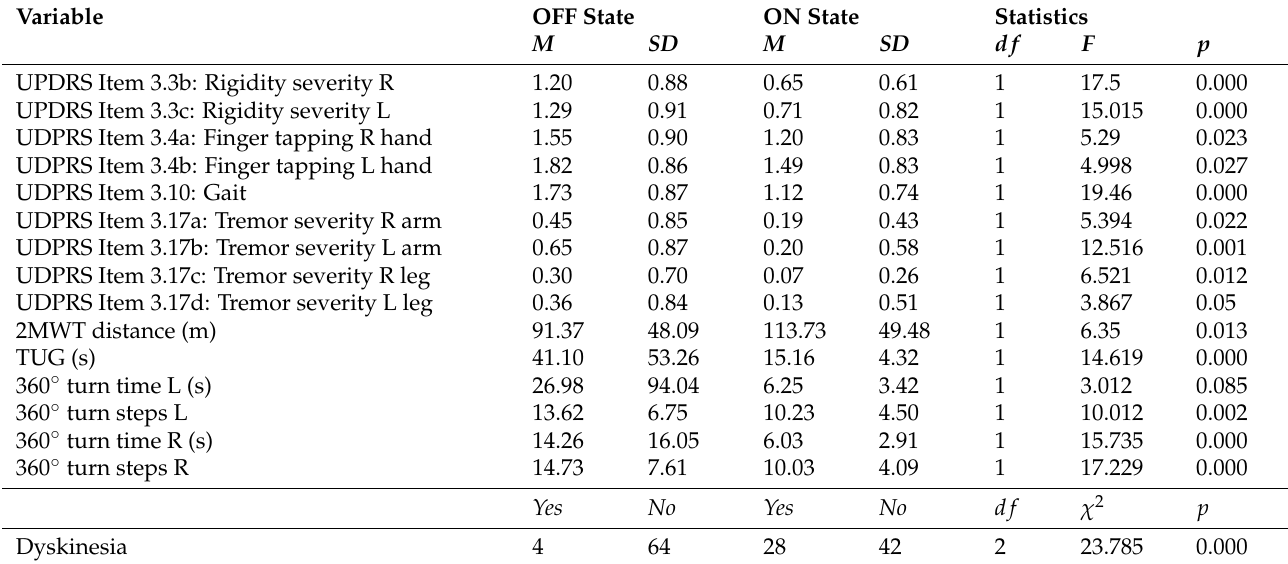
Table 3. ON-OFF state comparison within subjects for the main clinical scales and sub-item (UPDRS) and tests: 360 ◦ turn test (360 ◦ turn, time, and steps), Timed Up and Go (TUG), 2 Minute Walk Test (2MWT).